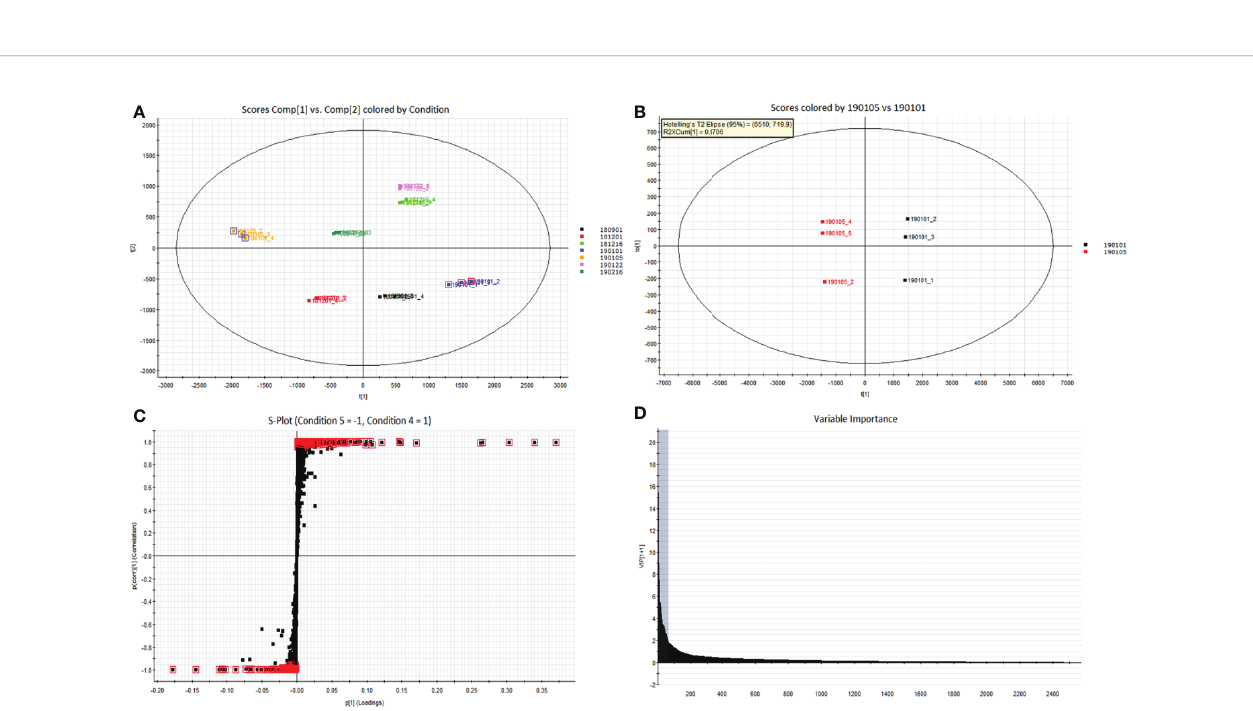
FIGURE 5 | Differential component analysis of different samples. (A) : PCA classi fi cation of seven batches of samples; (B) OPLS – DA analysis of No. 190101 and No. 190105 with signi fi cant differences; (C) S-Plot of No. 190101 and No. 190105; (D) VIP diagram of No. 190101 and No.